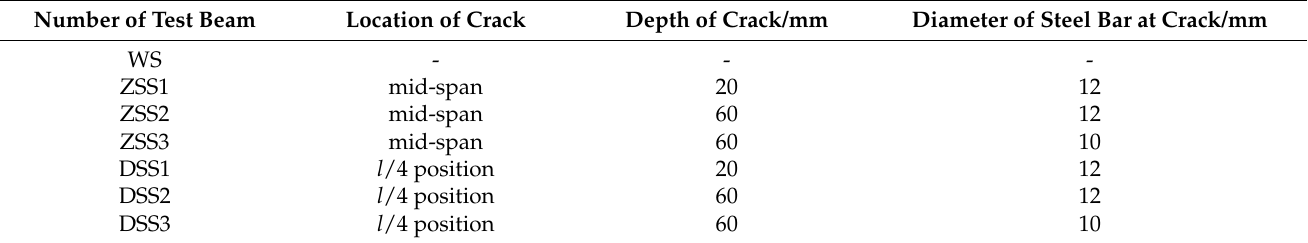
Table 1. Test-condition settings of T-beam for pre-cracking test.